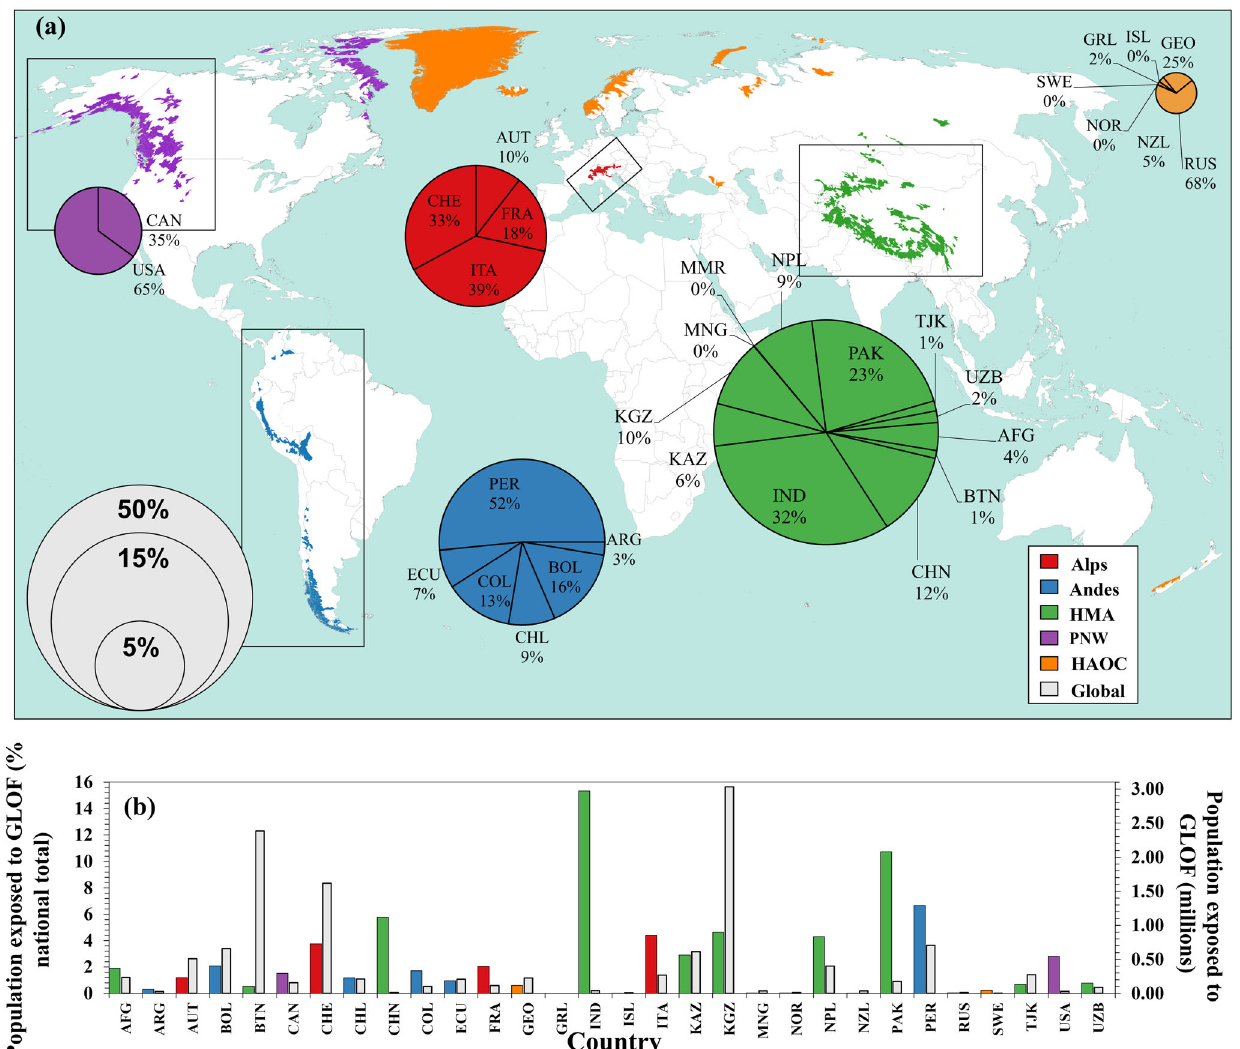
Fig. 1 | Global distribution of GLOF exposure. a Global distribution of glacial basins, colour-coded according to mountain range, with ‘ High Arctic and Outlying Countries ’ (HAOC) representing all basins outside of the four main ranges in this study (Alps, Andes, High Mountains Asia (HMA) and Paci fi c North West (PNW)). Pie charts show the proportion of exposed population as individual country